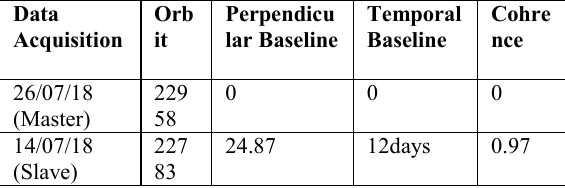
Table 1 Specification of data used for deformation in NCR, India